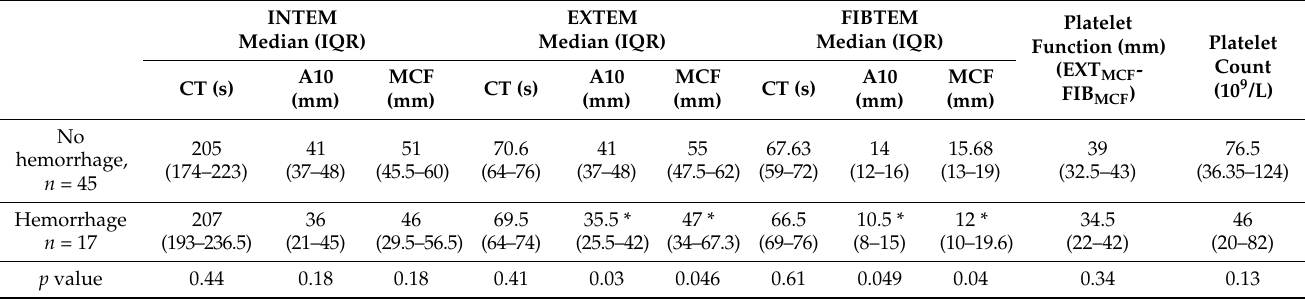
Table 6. Association of hemorrhage during defervescence with ROTEM and platelet count.